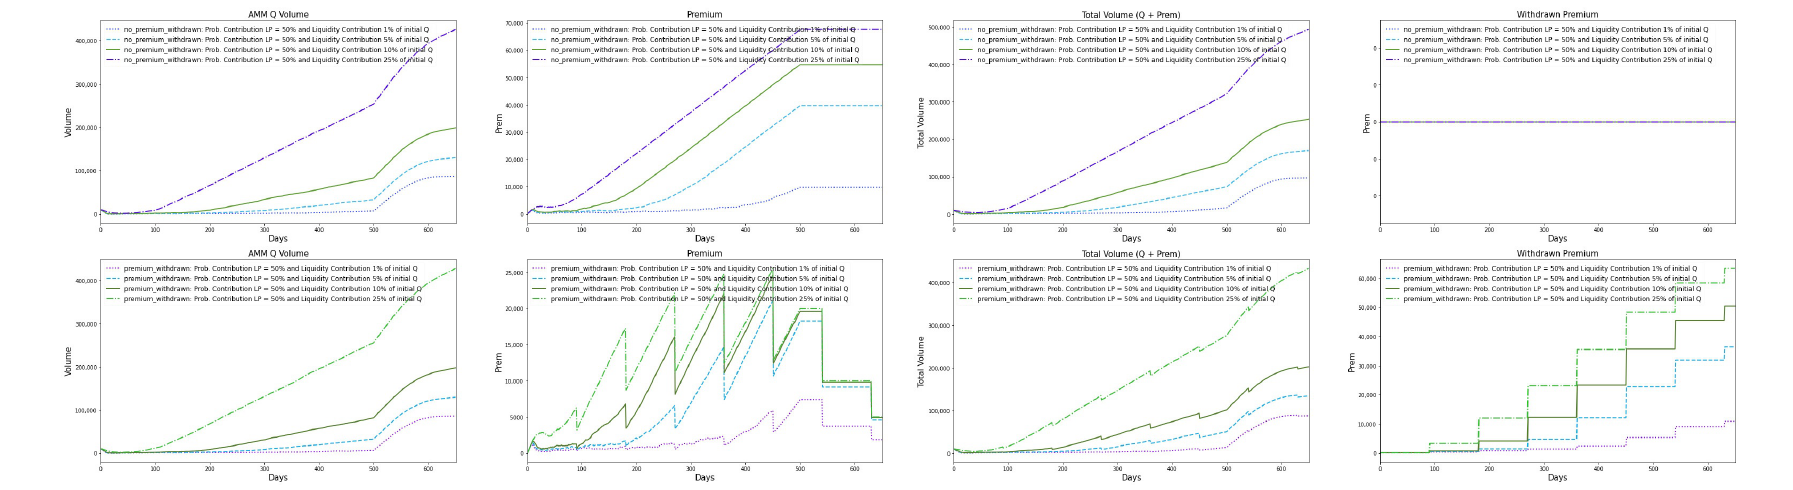
Figure A3. rkAMM Curves from simulation of scenario 1 and 90 days of withdrawal period.